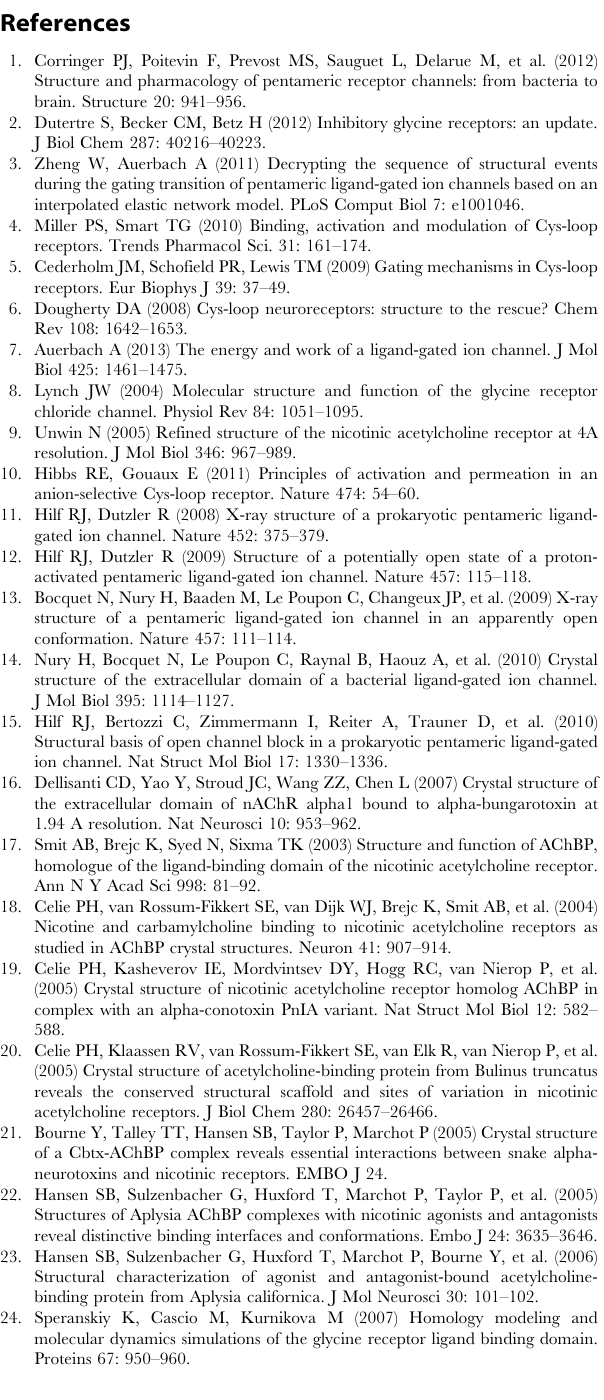
Figure S1 Root mean squared fluctuation profiles for individual subunits and the pentamer average (thick read line) over the last 360 ps. The individual fluctuation profiles differ predominantly in the regions of the N-terminus and loops. (TIF) Figure S2 Space-filled model showing subunit interface packing. Lysine residues are shown as Van der Waals spheres: K95 - orange, K116 - cyan, and K6 - blue.